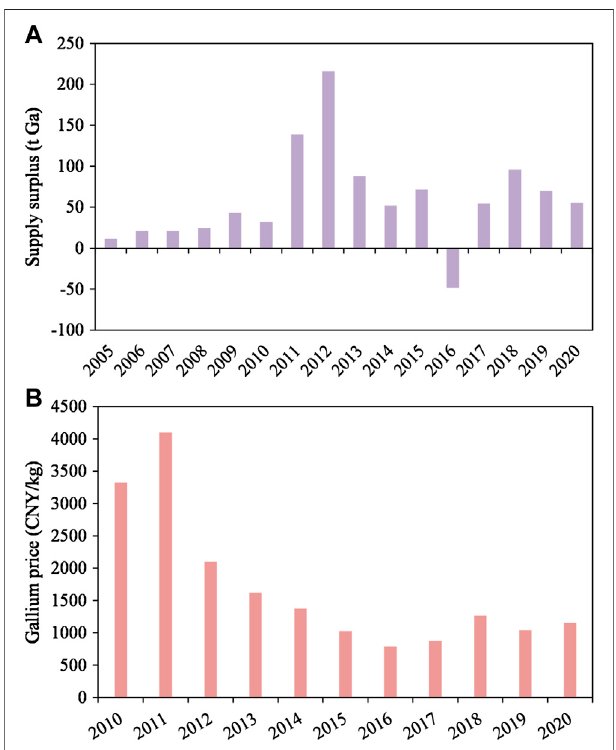
FIGURE 4 | Historical evolution of (A) gallium supply surplus, and (B) gallium price in China.